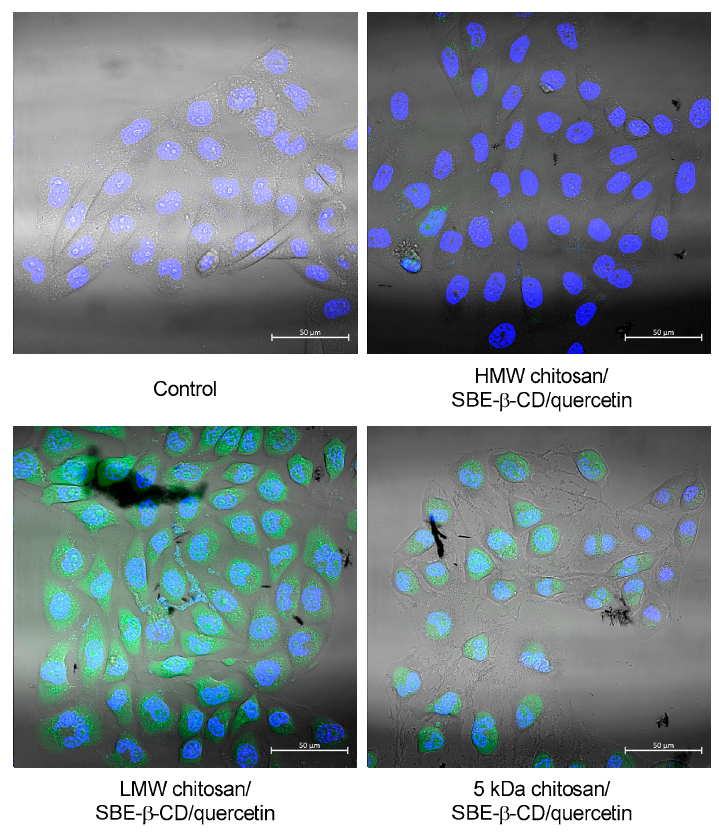
Figure 5. Uptake of FITC labeled chitosan-based delivery systems inside HeLa cells after 2 h of incubation. Each well was visualized under a confocal laser scanning microscope with fluorescence (green and blue) and bright fi eld.